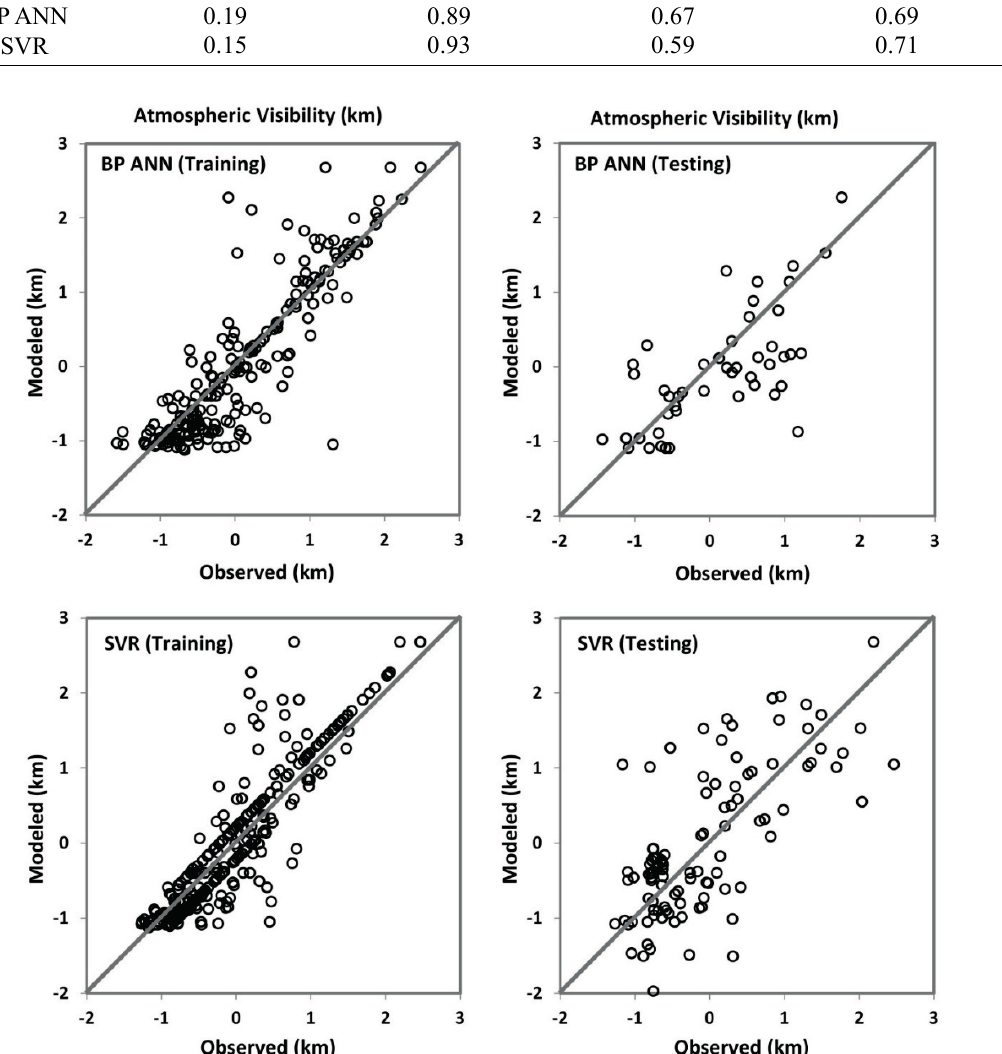
Fig. 2 Scatter plots of atmospheric visibility estimates from BP ANN (top) and versus in situ observations for training and testing